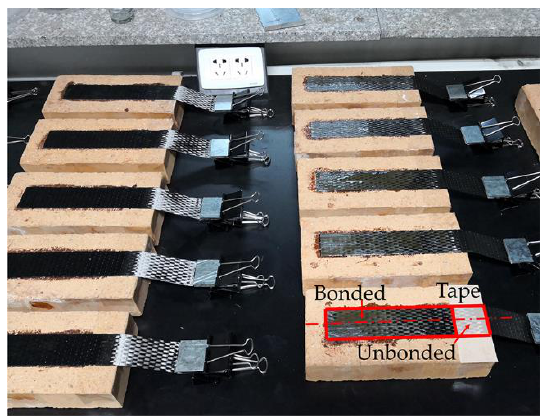
Figure 1. Carbon fiber reinforced polymer ( CFRP)-to-brick specimens.